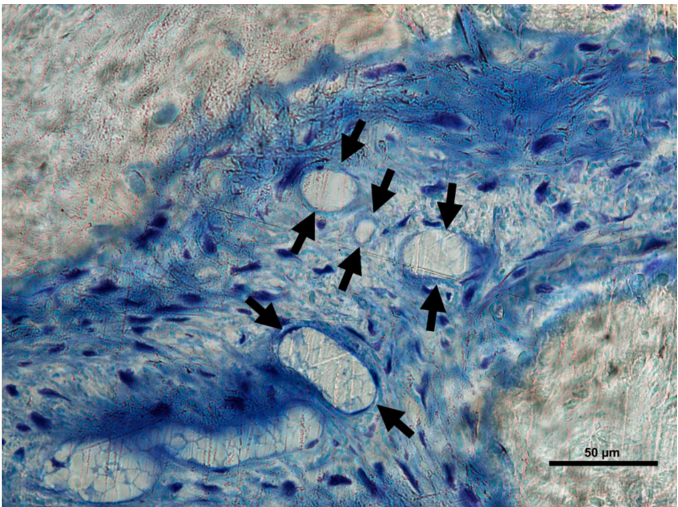
Figure 7. Bone histology image obtained in samples treated with Zn-loaded membranes by coloration with toluidine blue in experimental animals. At high magnification, vessels are clearly visualized (faced arrows) promoting and maintaining bone maturation.